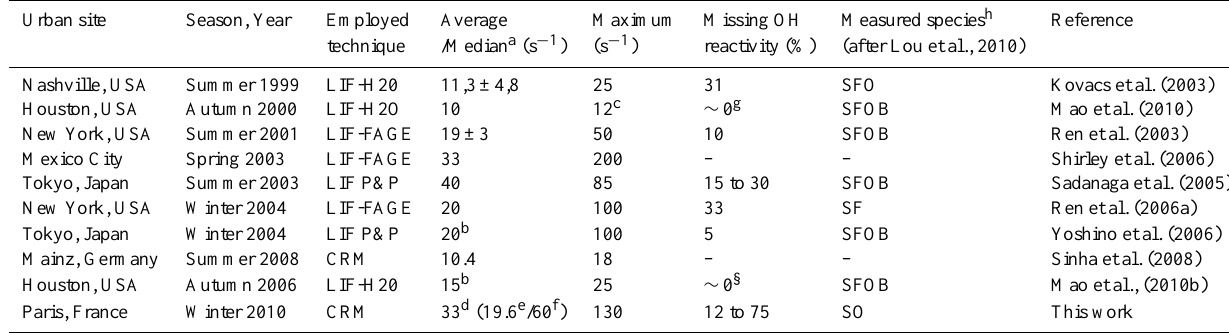
Table 4. Synthesis of OH reactivity levels measured in other urban atmospheres.